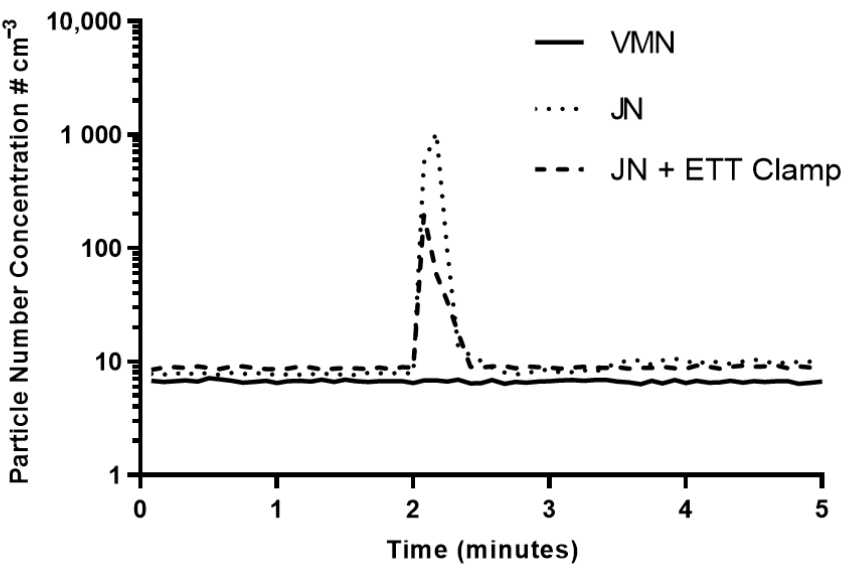
Figure 4. Average particulate number concentrations (PNC) for three runs for each test scenario over a five-minute period. The drug refill process was competed at the 2-minute timepoint.